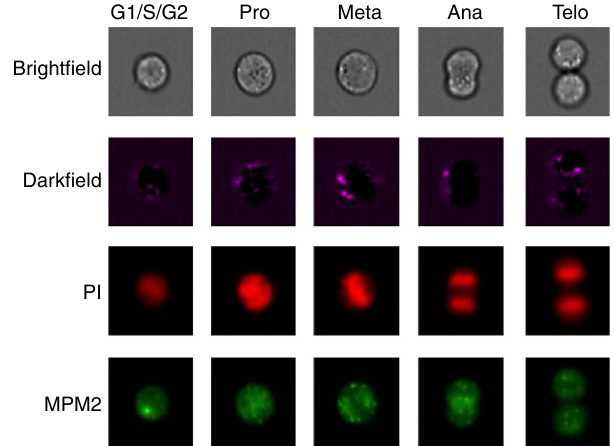
Fig. 2 Representative images for the cell cycle stages as measured